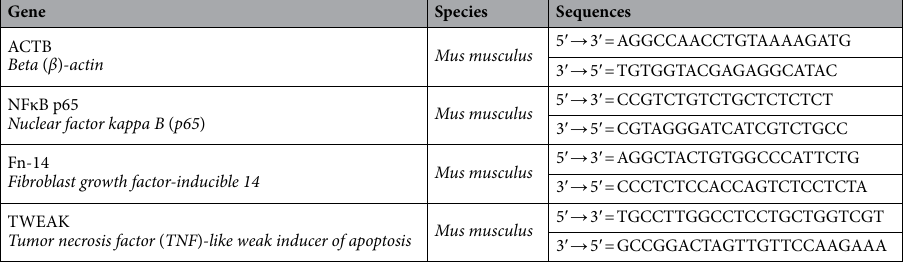
Table 3. Primer sequences used to detect target genes in the experiment